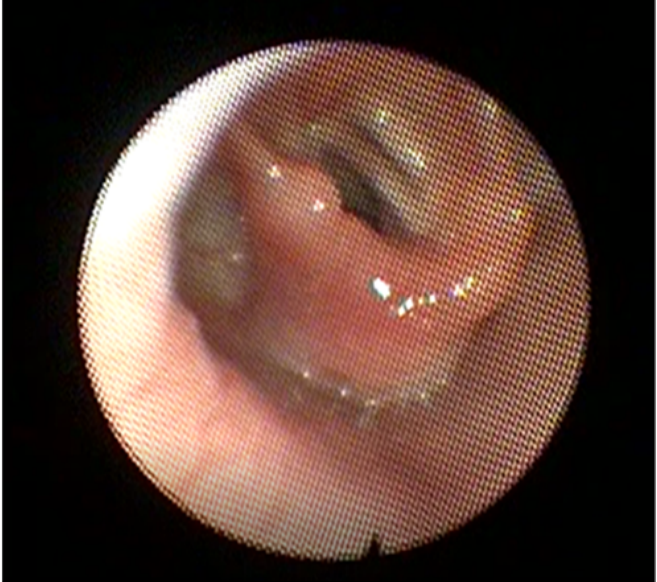
Figure 2. Flexible endoscopy image showing a unilateral vocal cord paralysis. The right vocal fold is abducted while the left is fixed in place.